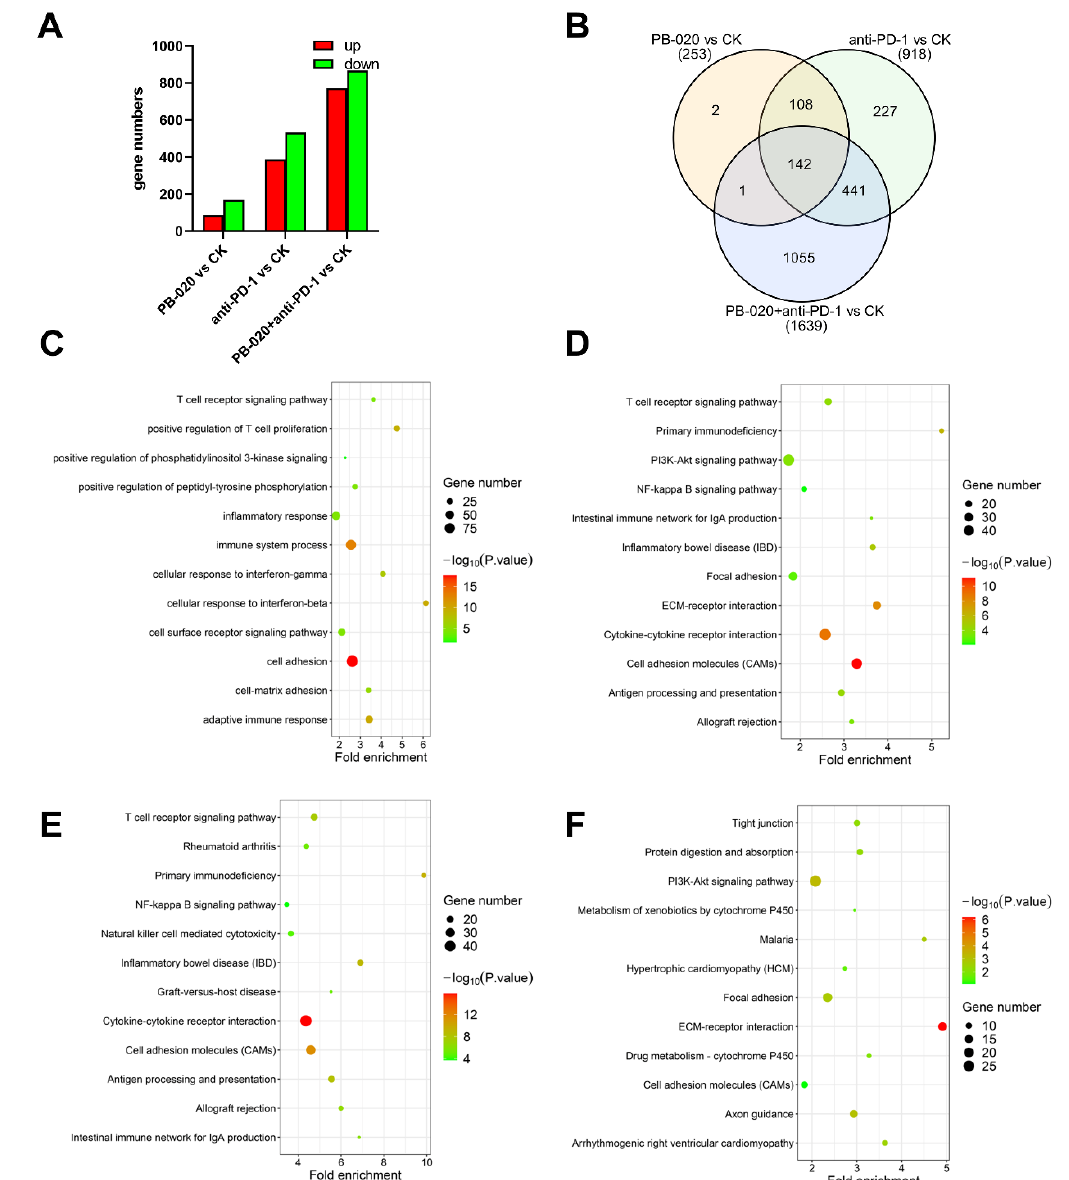
Figure 5. Bioinformatics analysis of DE genes in PB-020/anti-PD-1 combination versus control group mentioned in Figure 4. ( A ) Triplicate tumor tissues from the 4 groups were collected and subjected to RNA-seq analysis, and the up-regulated and down-regulated gene numbers are shown. ( B ) The Venn diagram shows the number of differentially expressed (DE) genes between the PB-020, anti-PD-1 and PB-020/anti-PD-1 combination group versus the control group, respectively. ( C ) GO biological process analysis of the identified DE genes in the PB-020/anti-PD-1 combination versus control group. ( D ) Enrichment analysis of the KEGG pathway of the identified DE genes in the PB-020/anti-PD-1 combination versus control group. ( E ) Enrichment analysis of the KEGG pathway of the identified up-regulated genes in the PB-020/anti-PD-1 combination group versus control group. ( F ) Enrichment analysis of the KEGG pathway of the identified down-regulated genes in the PB-020/anti-PD-1 combination group versus control group. The size and color of the circles represent the number of enriched genes and the adjusted p value, respectively.